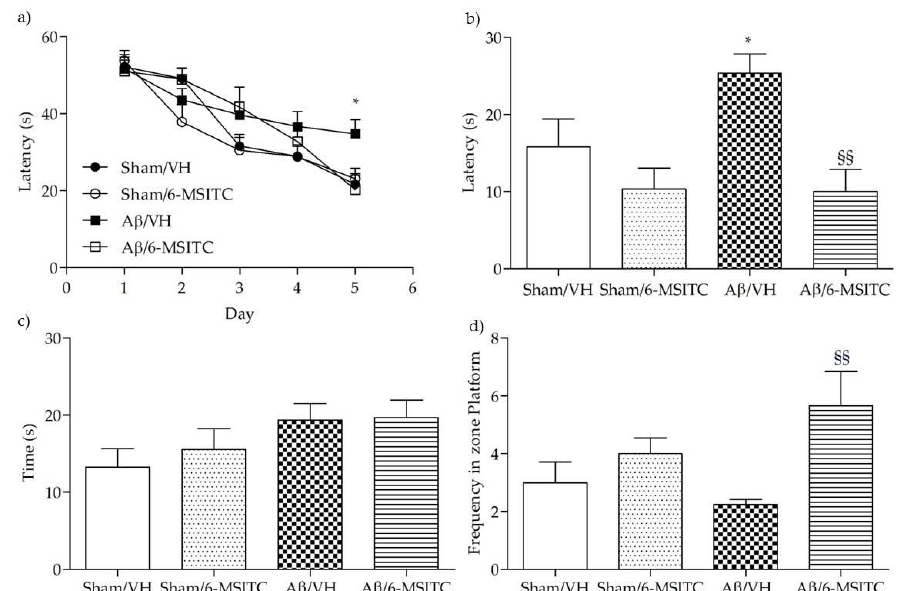
Figure 2. Effects of 6-MSITC (5 mg/kg) on the performance in the training ( a ) and probe trials ( b – d ) of the Morris Water Maze (MWM) test in A β 1-42 O-injected mice. The training trials were carried out for 5 days (four per day), the probe trial was performed on day 6. Escape latency ( b ), time spent in the opposite quadrant to the platform zone ( c ), and frequency in the platform zone ( d ) were recorded in the probe test. Values are expressed as mean ± SEM ( n = 10) ( a : * p < 0.05 vs. Sham/VH group; b : * p < 0.05 vs. Sham/VH group, §§ p < 0.01 vs. A β /VH; d : §§ p < 0.01 vs. A β /VH; ANOVA, post hoc test